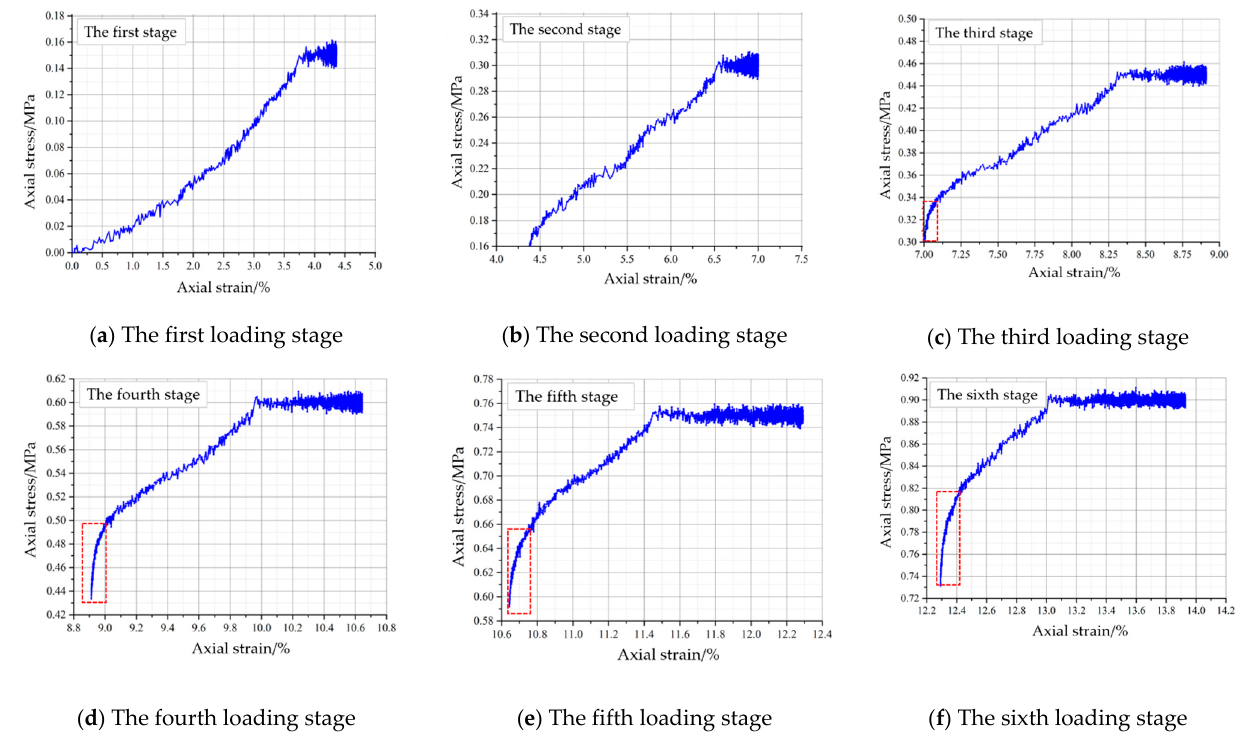
Figure 10. The periodic stress-strain curves of sample S-1 at each loading stage.